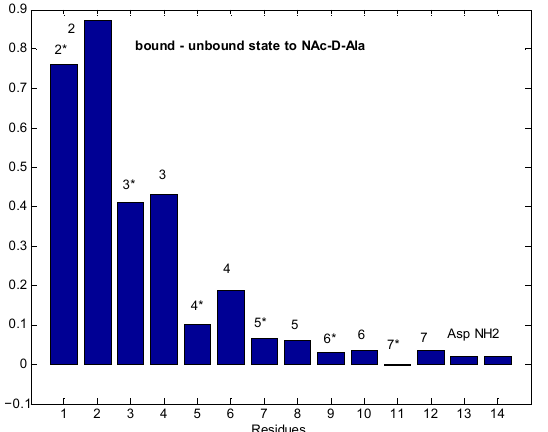
Figure 9. Differences in water saturation efficiency between the free eremomycin dimer and N -Ac- D -Ala loaded dimer. Bars close to 1 unit mean huge differences in water accessibility due to ligand binding, while values close to 0 mean no change in water access to that site upon binding. Asterisks indicate the same monomeric units within dimers. Numbers on the top of bars mean residue numbers, according to the scheme of Figure 1.